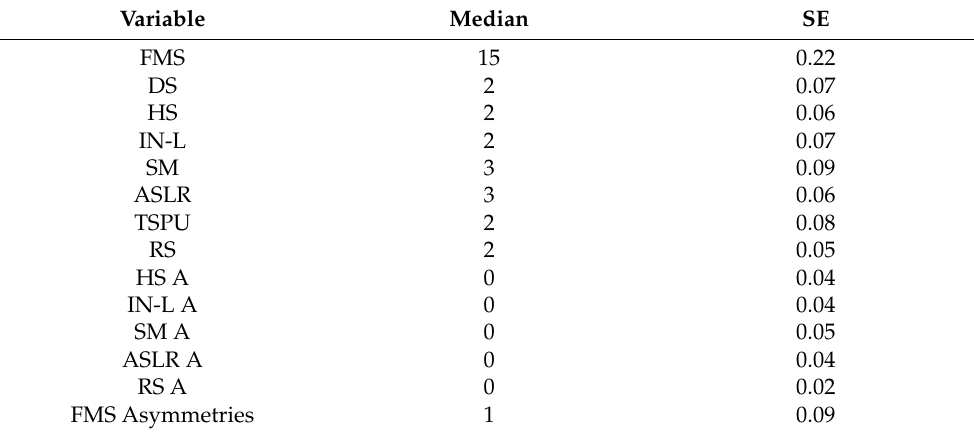
Table 2. Characteristics of the FMS